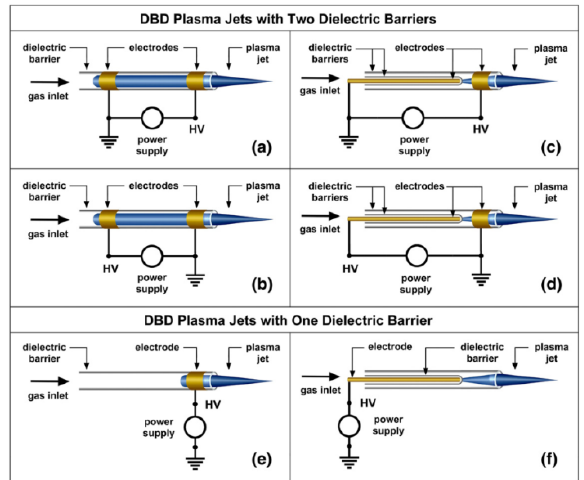
fig 2 : Different configurations of DBD plasma jet [13]